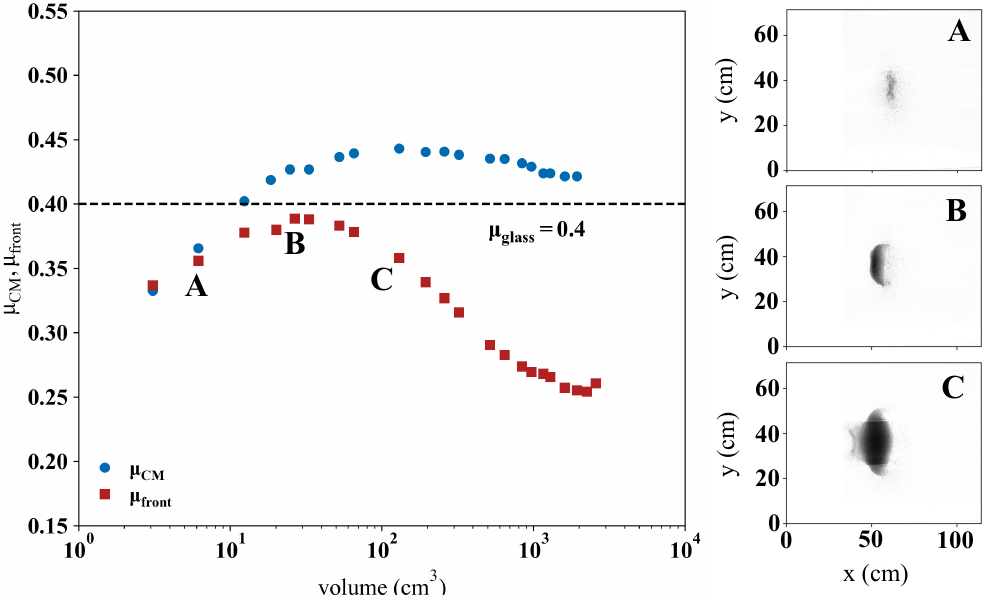
Figure 5. Left: E ff ective friction µ CM = H CM / L CM and µ front = H / L vs. initial volume. Right: Intensity (normalized) images during landslide motion t = 0 . 5s after the junction is first reached, with A , B and C corresponding to the data with the same notation on the left. As the initial volume increases, the landslides become more dense and less gaseous in appearance. This change in appearance corresponds with the non-monotonic behavior of the e ff ective friction µ front and µ CM